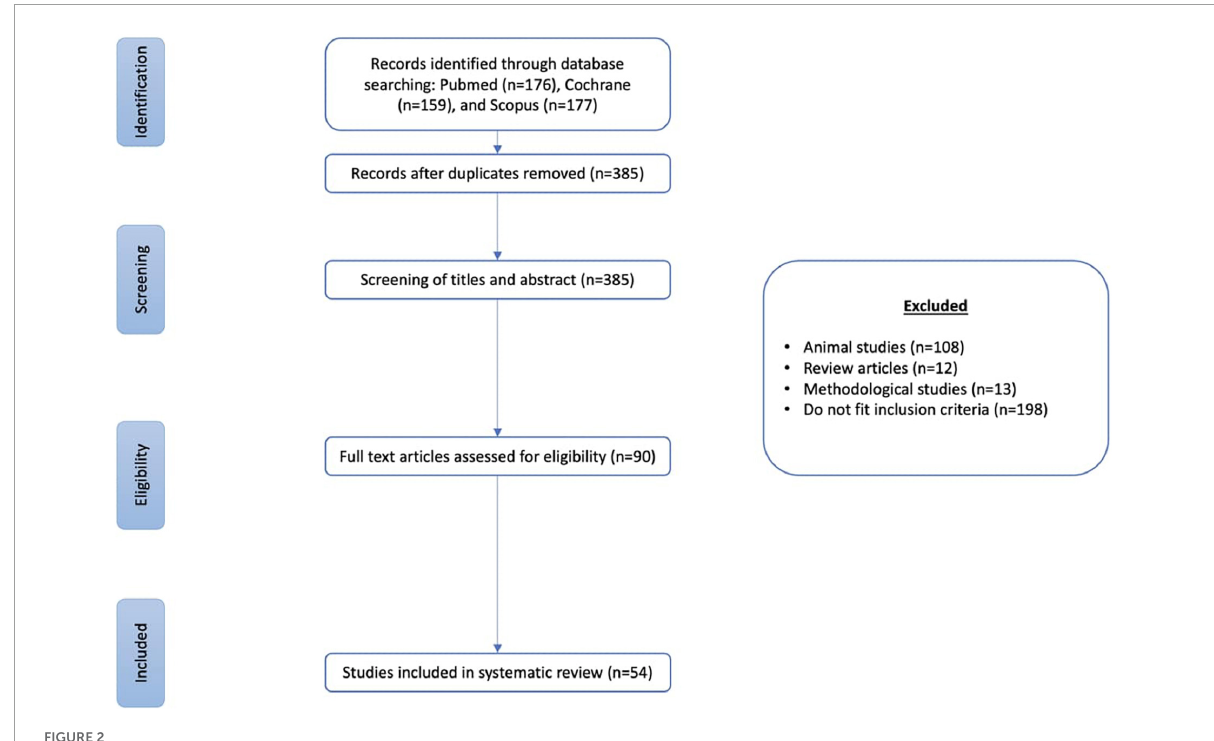
FIGURE2 Studies selection flow